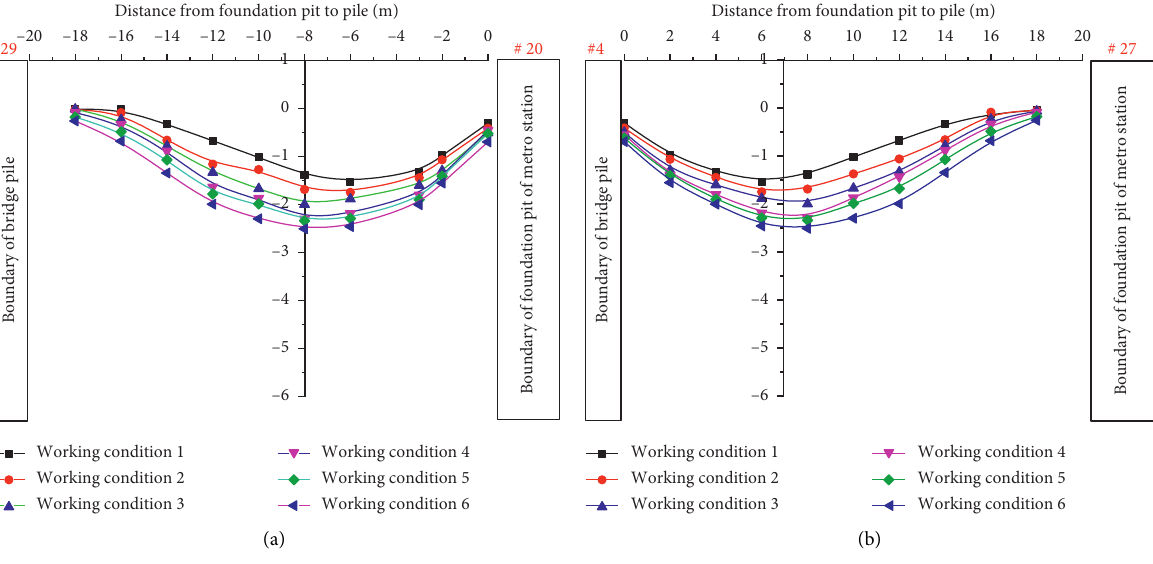
Figure 18: Surface settlement curves under different working conditions. (a) Line 29–20. (b) Line 4–27.